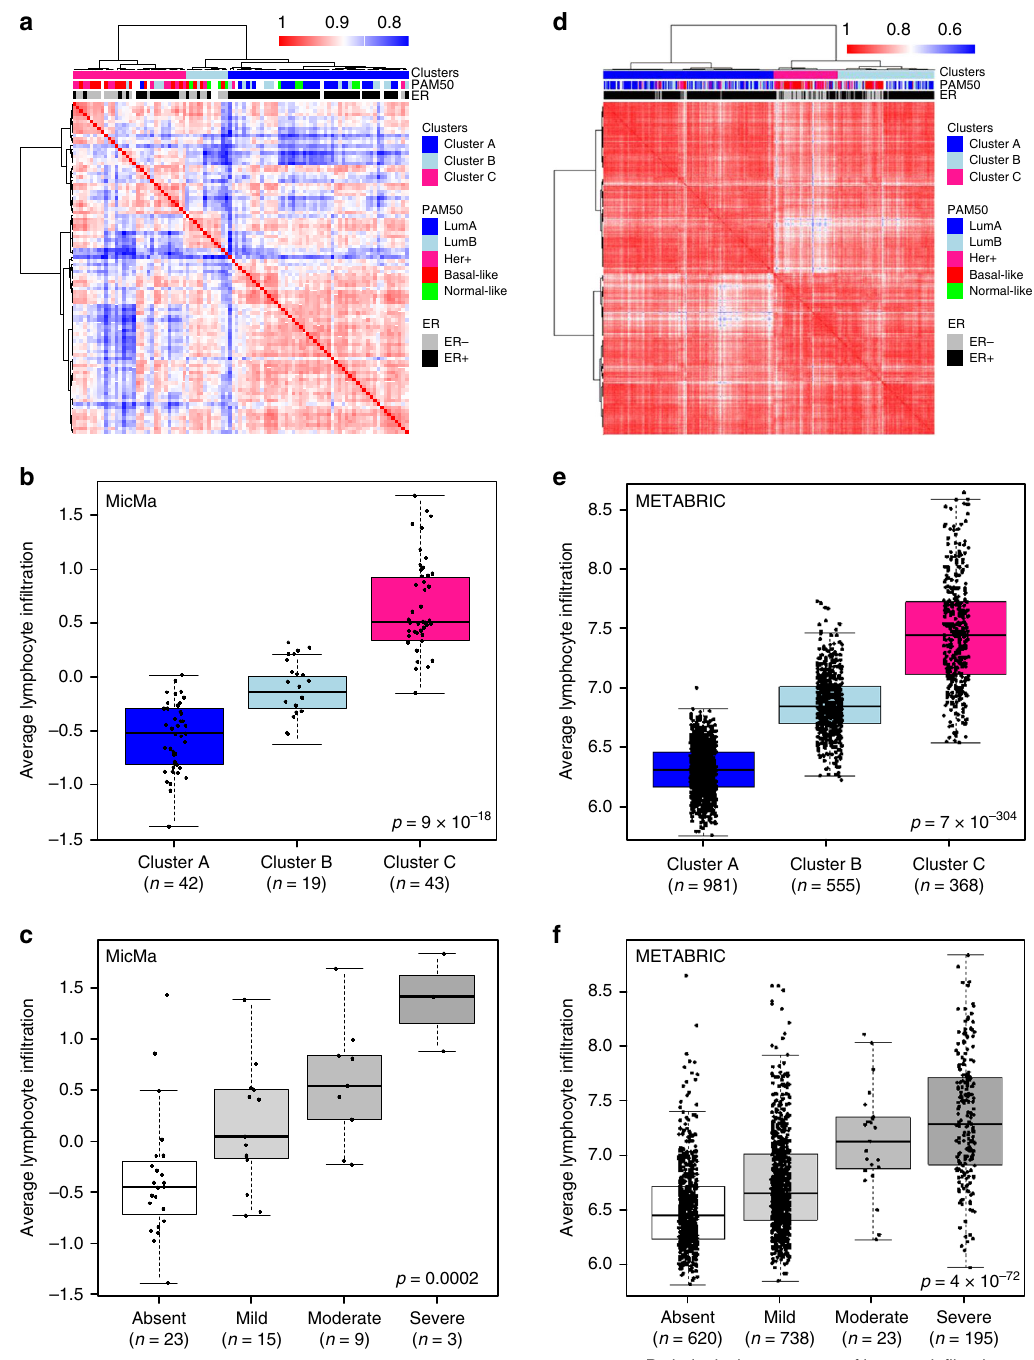
Fig. 1 Immune clusters are associated with total immune in fi ltration. a , d Gene expression was measured in 95 FFPE MicMa ( a ) and 1904 fresh frozen METABRIC samples ( d ). Unsupervised clustering using correlation distance and ward. D linkage of the correlation matrix assesses the relation between patients according to the expression of the genes on the PanCancer Immune Pro fi ling array. All 760 genes on the array were used for clustering the MicMa cohort, while 509 genes, which corresponds to genes (out of the 760) found in all datasets, were used to cluster the METABRIC. Annotations of the samples on the top of the heatmap indicate histopathological features: PAM50 subtype, ER status as well as the three clusters identi fi ed by the cutree method. b , e In the MicMa ( b ) and the METABRIC ( e ), lymphoid scores quantify lymphoid in fi ltration which was calculated from a set of genes ’ markers of lymphocyte as de fi ned by the algorithm Nanodissect. Lymphoid scores are represented in boxplots according to immune clusters with Kruskal – Wallis test p values. c , f H&E-stained tumor tissue samples ( c , MicMa, n = 50 and f , METABRIC, n = 1904) were categorized by an experienced pathologist according to the level of tumor-in fi ltrating immune cells. Boxplots represent the average lymphocyte score from Nanodissect according to pathologists ’ classi fi cations. Kruskal – Wallis test p values is denoted. The line within each box represents the median. Upper and lower edges of each box represent 75th and 25th percentile, respectively. The whiskers represent the lowest datum still within [1.5 × (75th − 25th percentile)] of the lower quartile, and the highest datum still within [1.5 × (75th − 25th percentile)] of the upper